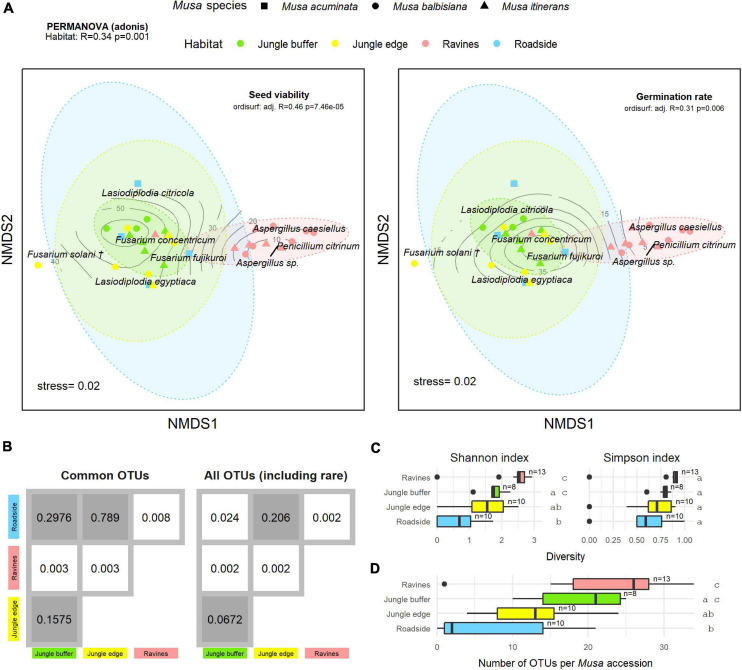
(A) Non-metric multidimensional scaling (NMDS) plot of the most common OTUs, produced with metaMDS, fitted with post-storage seed viability (left) and germination rates (right). Contour lines indicate the fit of the seed viability and germination rate variables to the ordination using the ordisurf function, showing which points are associated with higher or lower seed viability. Each point represents one Musa accession, with shape showing host Musa species and colour showing habitat, while OTUs are shown in italic text. (†) Fusarium solani = Neocosmospora solani (Sandoval-Denis et al., 2019). Ellipses were generated with the stat_ellipse function in ggplot2. The PERMANOVA result in the top left indicates significant difference in endophyte community composition between habitats. (B) Matrix of pairwise PERMANOVA p-values showing whether endophyte community was significantly different between pairs of habitats, both for the subset of common OTUs visualised in the NMDS and including rare OTUs. Grey boxes indicate non-significant p-values (>0.5). Diversity according to Shannon and Simpson indices (C) and abundance of OTUs (D) per Musa accession in each habitat. Groups with significant difference of means as calculated by TukeyHSD are shown by letters on the right of the plots. Sample size (number of accessions) is shown to the right of boxes.